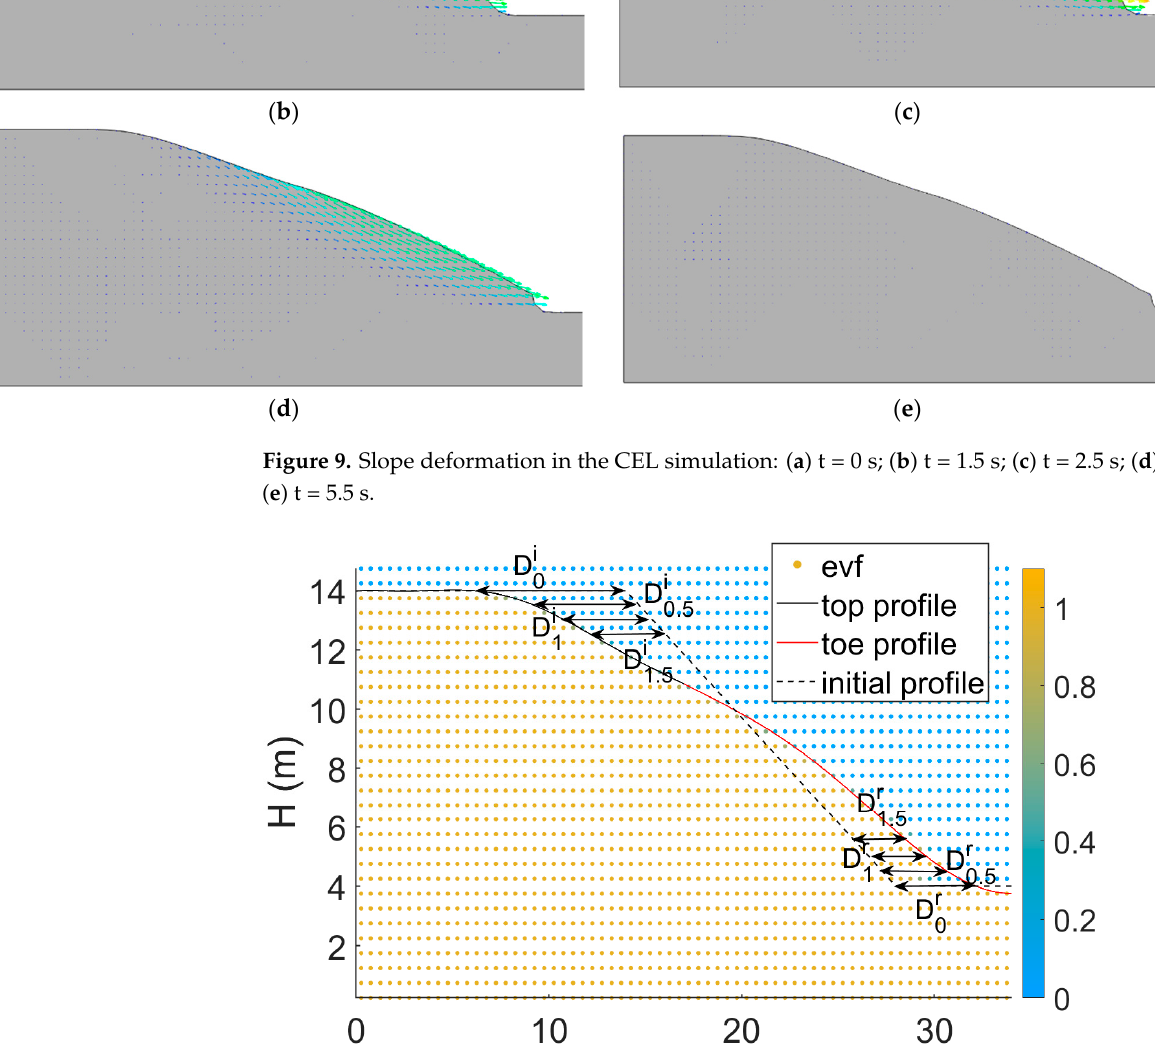
( b ) Figure 11. Variation of runout and influence distance with time from CEL simulations: ( a ) distance of the slope top with time (influence distance); ( b ) distance of the slope toe with time (runout dis- tance). 3.1. Effect of Soil and Rainfall Parameters Rainfall-induced landslides are affected by many factors, including soil parameters, initial saturation, rainfall intensity, rainfall duration, and slope geometry. Therefore, it is necessary to conduct a sensitivity analysis, which is achieved by simply varying one parameter but fixing the other parameters in this study. In this section, seven parameters